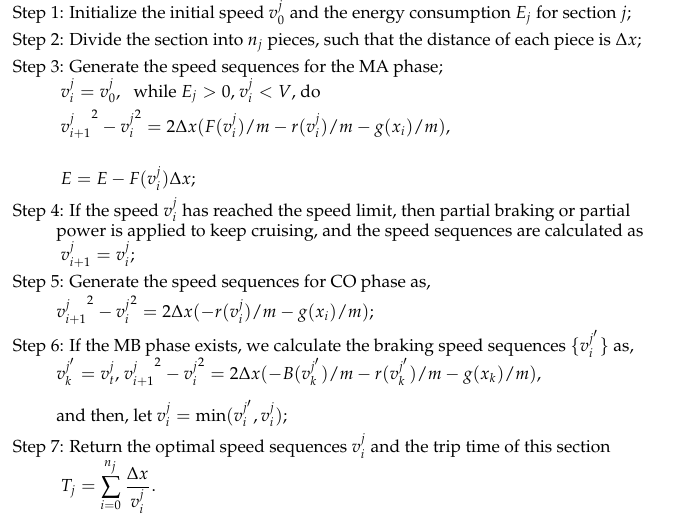
Algorithm 1: calculation of the energy-efficient driving strategy for a given